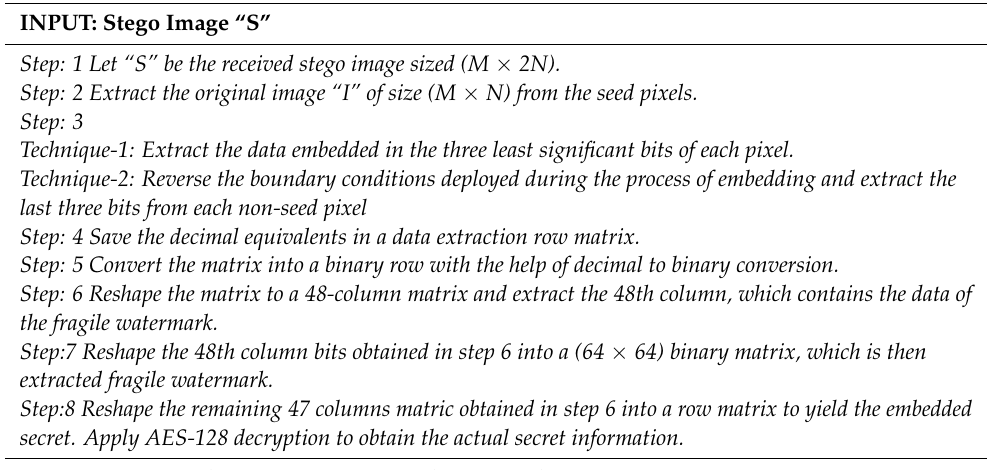
Algorithm 2: Watermark and secret data extraction from